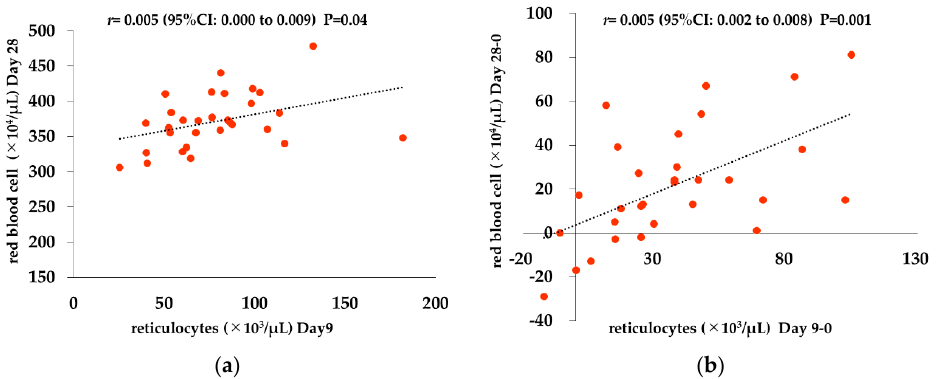
Figure 3. Correlation between reticulocytes and red blood cell counts. ( a ) Ret count on Day 9 and RBC count on Day28: Ret and RBC counts showed a significant positive correlation ( r = 0.005 [95%CI: 0.000 to 0.009; p = 0.04]). ( b ) Increase of Ret count from day 0 to day 9 and that of RBC count from day 0 to day 28: Increase of Ret and RBC counts showed a significant positive correlation ( r = 0.005 [95%CI: 0.002 to 0.008; p = 0.001]). Pearson product-moment correlation coe ffi cient and univariable linear regression model were